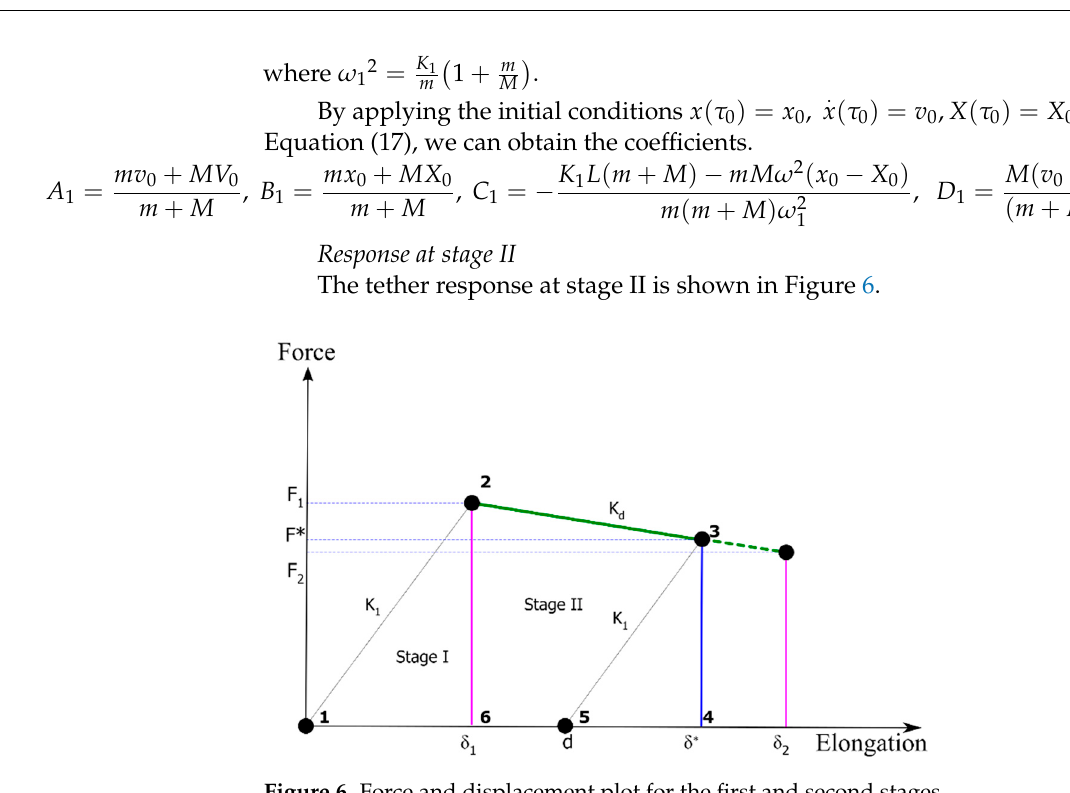
Figure 6. Force and displacement plot for the first and second stages.